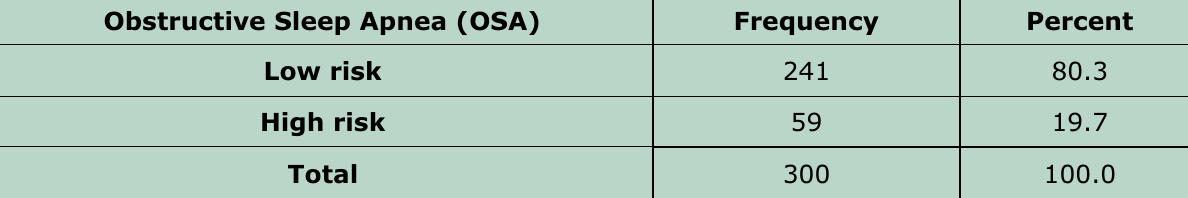
Table-II: Frequency distribution of risk of Obstructive Sleep Apnea (OSA).